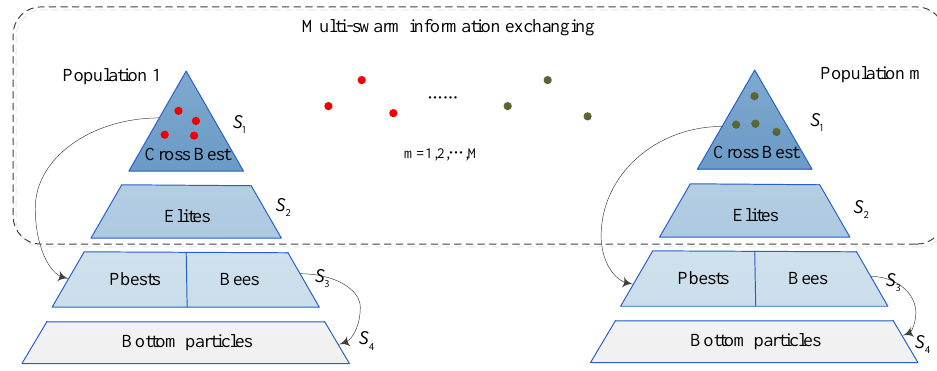
Figure 3. The hierarchical illustration of the ParaPA algorithm with multi-swarm